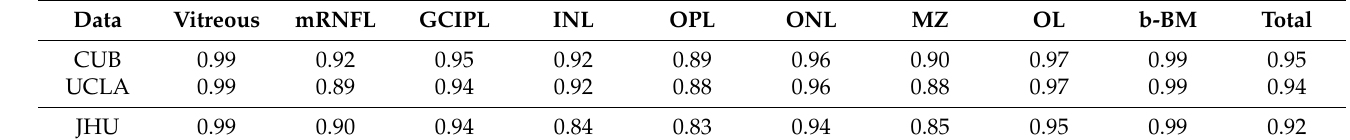
Table 6. DSC between CCU-INSEG’s outcome and the manually segmented data.